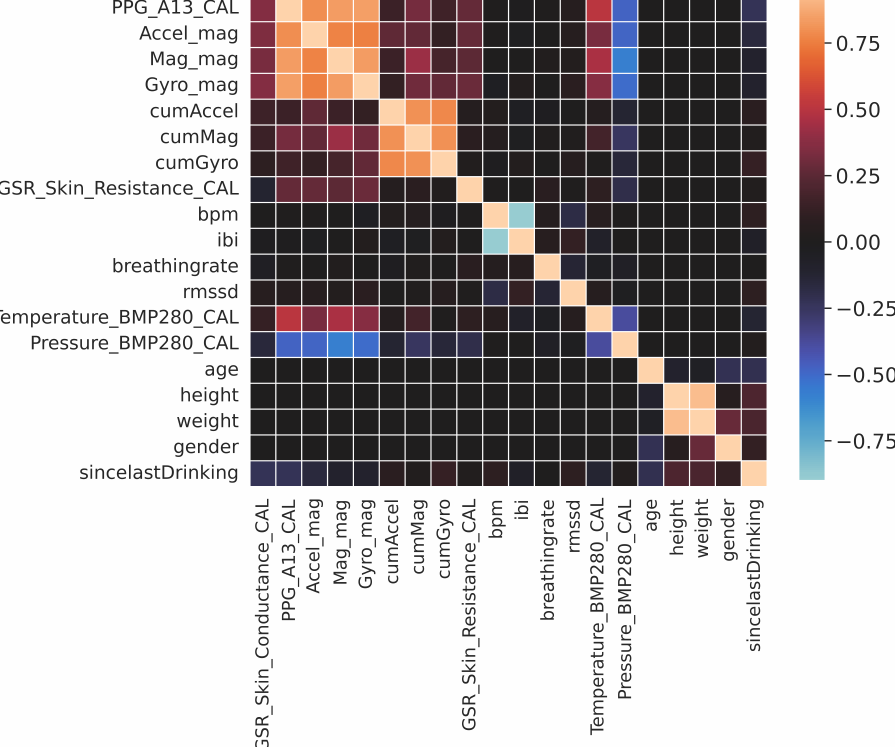
Figure 6. Features’ correlation matrix (please refer to Table 2 for the meaning of the features).